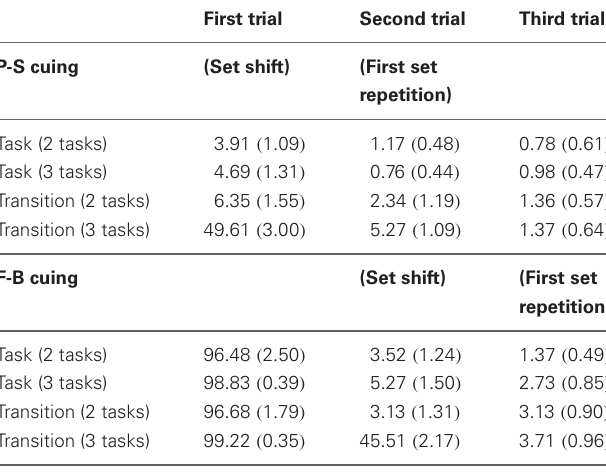
Table 4 | Mean (standard error) percentages of errors across conditions and